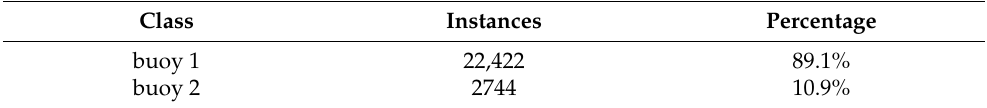
Figure 9. Mosaic image augmentation.